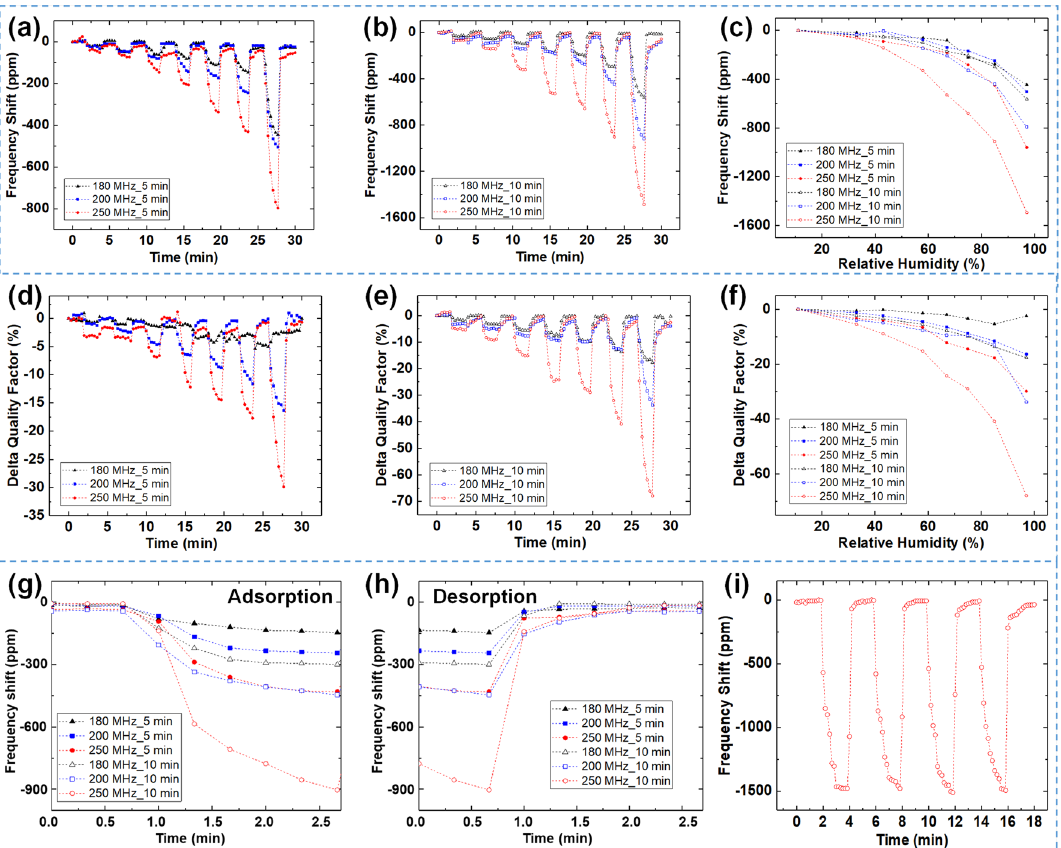
Figure 3. The frequency responses of the SAWRs with different GO masses under the various RH conditions. ( a,b ) The f 0 shifts of the SAWR humidity sensors with different GO ESD times for 5 min and 10 min, respectively. ( c ) The shifts in f 0 as a function of the deposited GO mass and the operating frequencies at different RH levels. ( d,e ) The device Q with 5 min and 10 min ESD time as a function of the exposed RH levels. ( f ) The device Q fluctuations of each SAWR sensor under the various RH levels. ( g,h ) The adsorption and desorption tests of the SAWR sensors under the 85% RH level. ( i ) The frequency repeatability test of 250 MHz_10 min sensor at 97% RH